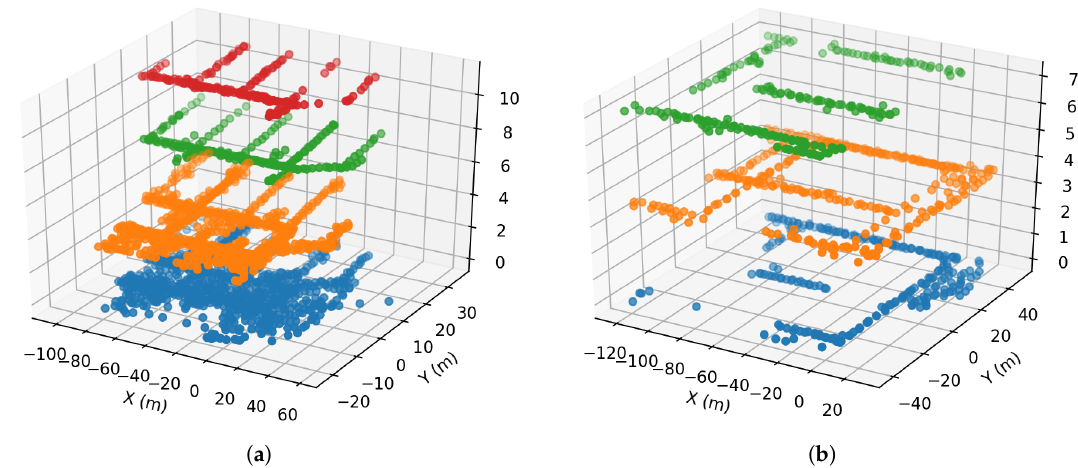
Figure 10. The geometric positions of fingerprints in ( a ) Building One and ( b ) Building Two. (The dataset is from Reference